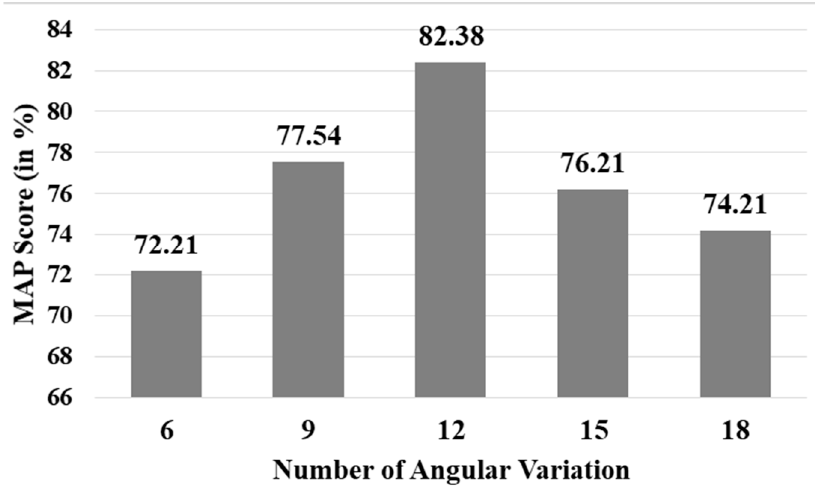
Figure 10. Comparison of the MAP scores with the varying number of angular variations in HT on the dataset, prepared for ablation study.